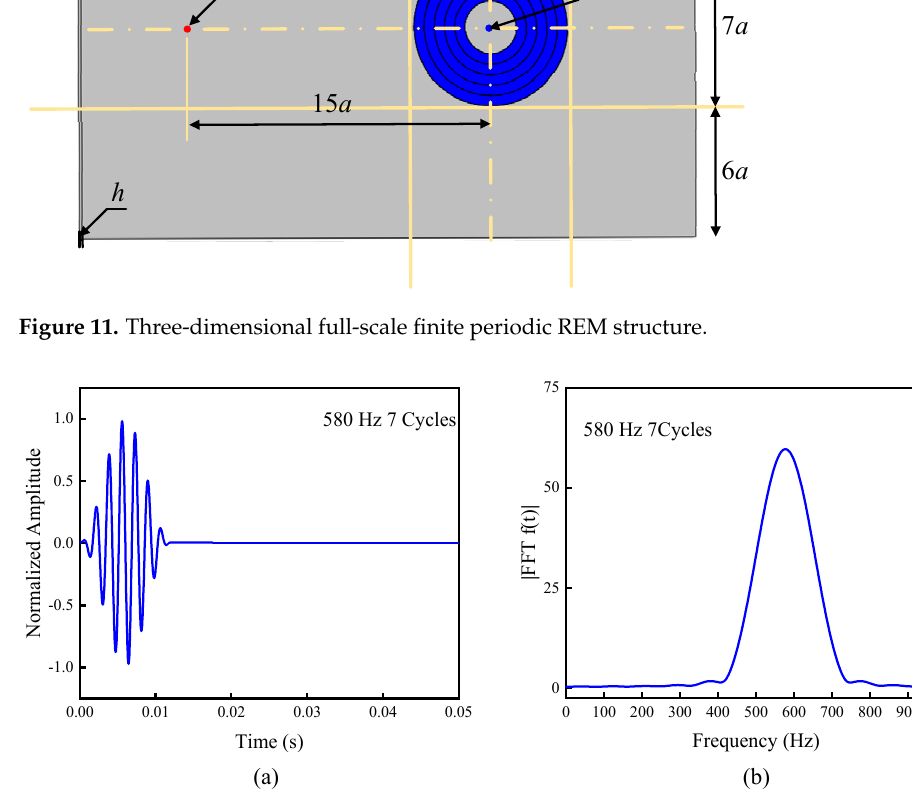
Figure 12. 580 Hz, 7-cycle excitation signal. ( a ) Time–history curve of the excitation signal and ( b ) frequency content of the excitation signal.